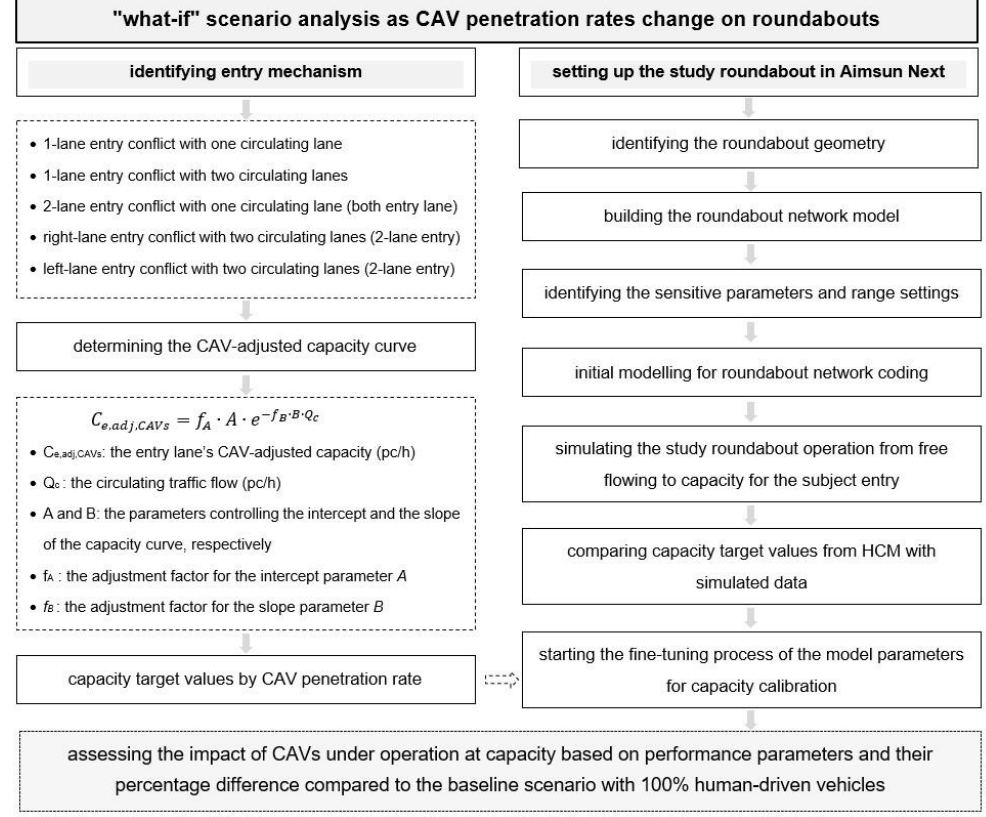
Figure 1. The summary framework of the proposed methodology. Source: Own research started from data presented in [2].